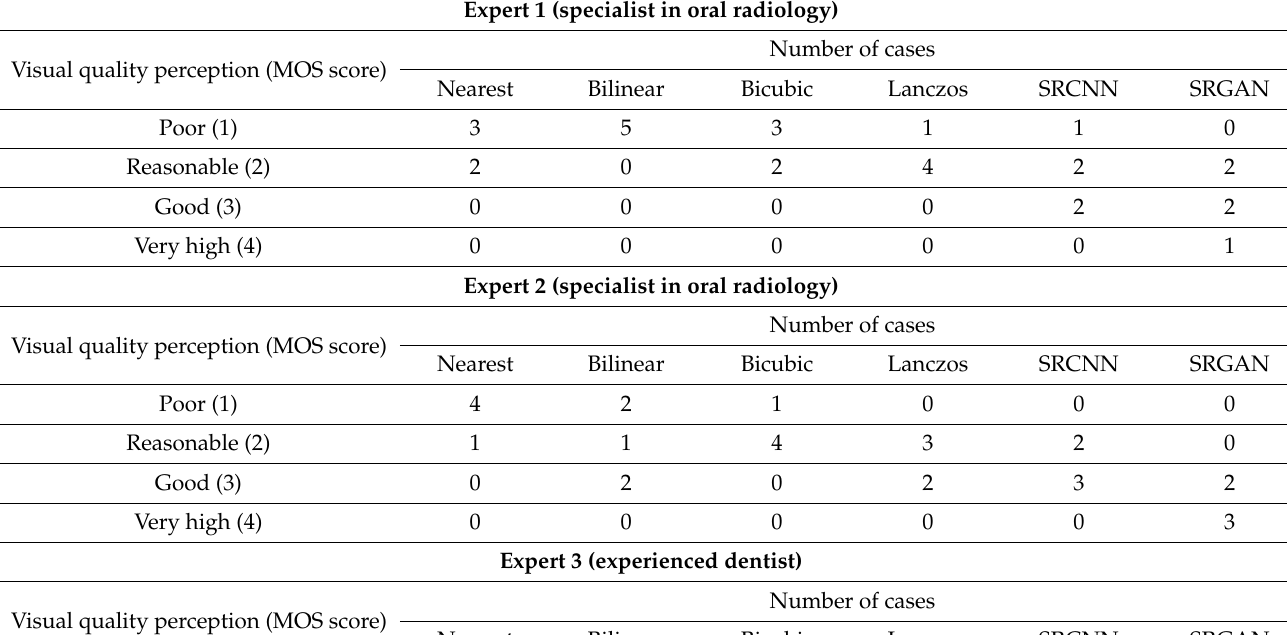
Table 1. Observers’ ratings and respective mean opinion scores (MOS) for the visual grading characteristics (VGC) analysis. Expert 1 (specialist in oral